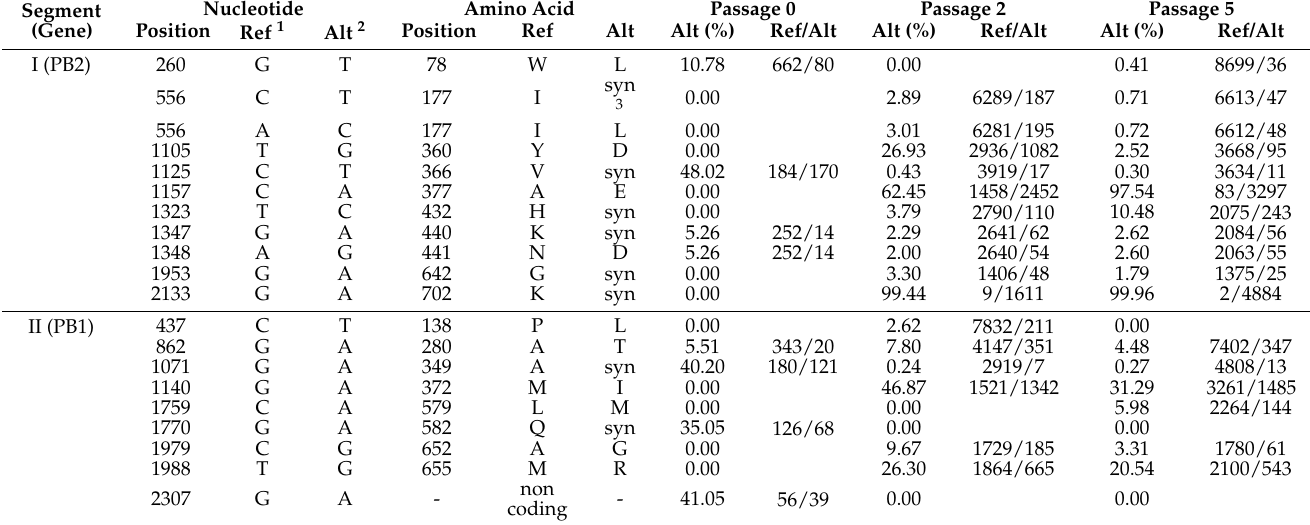
Table 1. Single nucleotide variants of equine influenza virus H3N8 strain A/equine/Pulawy/2005 passaged in embryonated chicken